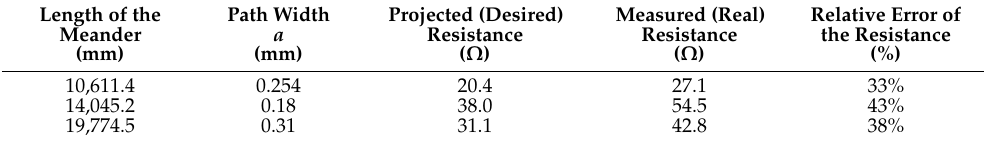
Table 2. A comparison of the desired and measured resistances for arced paths with h = 0.035 mm. Length of the